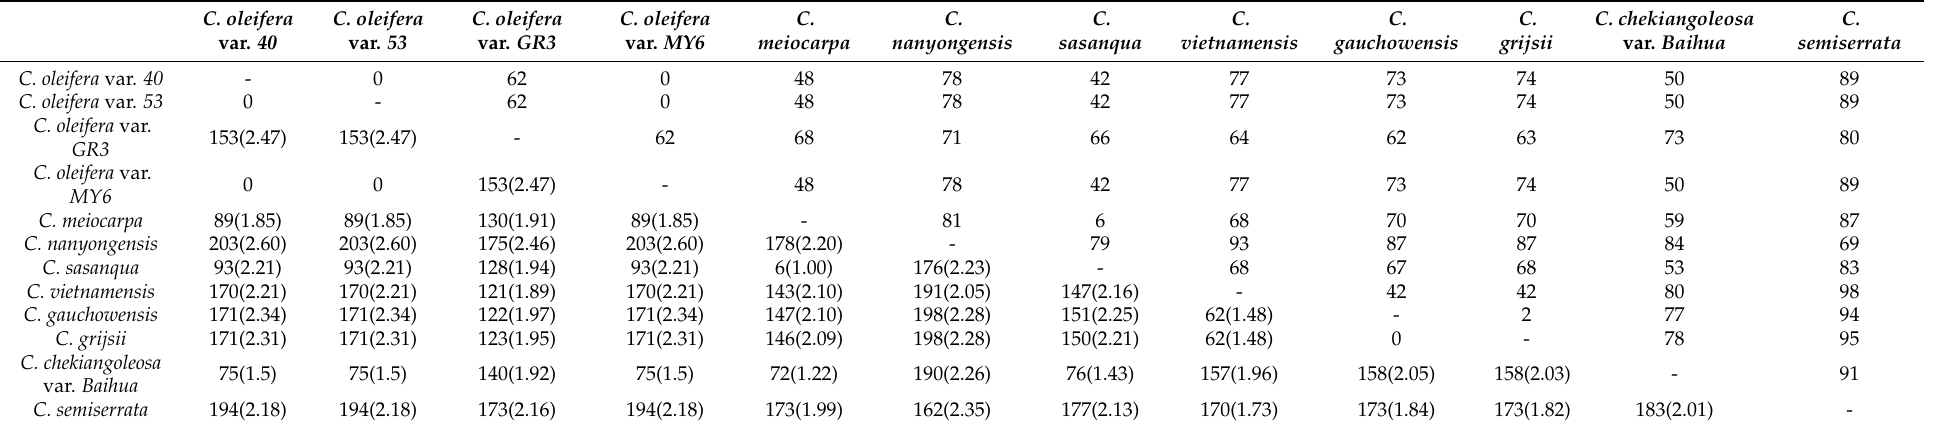
Table 6. The numbers and ratios of SNPs and InDels in the 12 Camellia cp